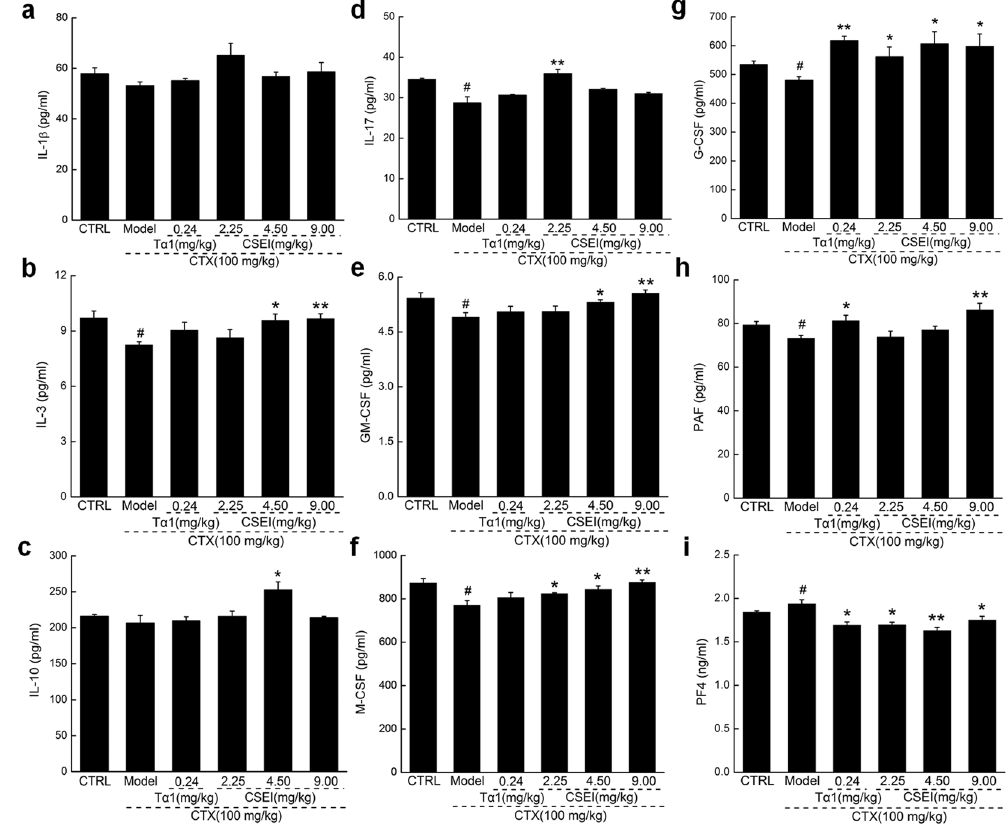
Figure 5. After a 3-day CTX (100 mg/kg) injection and a 21-day CSEI (2.25, 4.5 and 9 mg/kg) treatment, the levels of nine factors related to hematopoietic function including IL-1 β ( a ), IL-3 ( b ), IL-10 ( c ), IL-17 ( d ), GM- CSF ( e ), M-CSF ( f ), G-CSF ( g ), PAF ( h ) and PF4 ( i ), in the mice plasma were detected by ELISA method. The data are expressed as the means ± S.E.M. (n = 10). # P < 0.05 versus the control group, * P < 0.05 and ** P < 0.01 versus the model